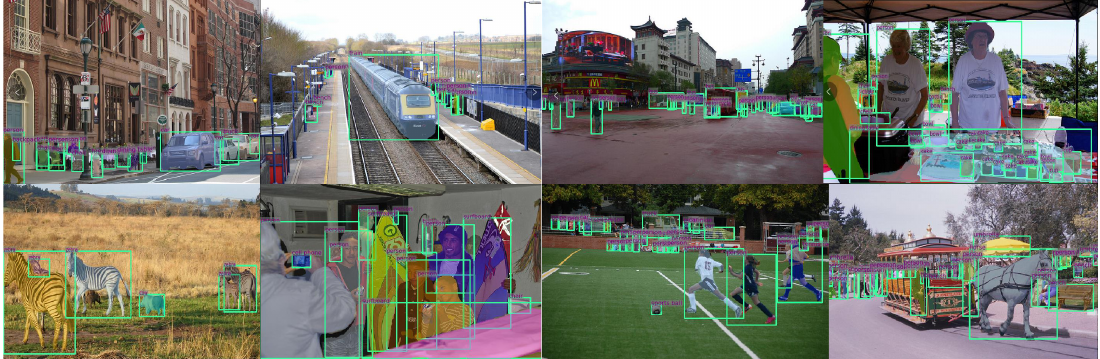
Figure 6. Selected examples of the test results on the COCO test-dev images, using the proposed APN and running at 5 fps.